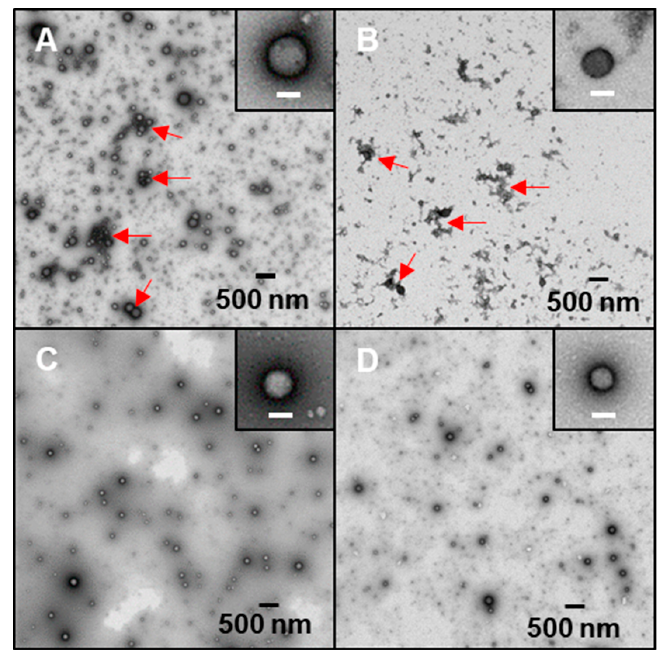
Figure 4. TEM images of freshly prepared nanoparticles.( A ) UH1 (unheated complex nanoparticles with low concentration of oxidized dextran), ( B ) and ( C ) NP1-30 and NP1-60 (30 and 60 min-heated complex nanoparticles with low concentration of oxidized dextran, respectively), ( D ) NP2-60 (60 min-heated complex nanoparticles with high concentration of oxidized dextran).